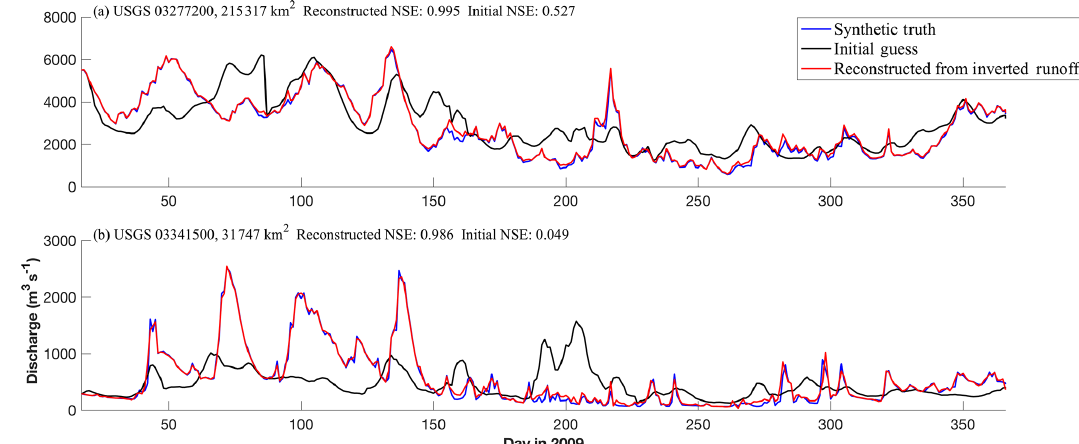
Figure 4. Reconstructed discharge time series during 2009 for 2 of the 25 evaluation sites when the ISR model was run using the clima- tological initial guess of runoff conditions. The blue line represents the synthetic truth discharge used in the inverse routing, the black line illustrates the discharge derived from our initial guess of runoff, and the red line illustrates the reconstructed discharge. NSE values are given for the initial guess and the reconstruction in relation to the synthetic